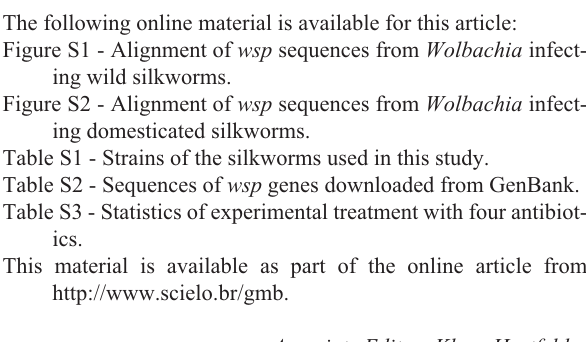
Figure S1 - Alignment of wsp sequences from Wolbachia infect- ing wild silkworms. Figure S2 - Alignment of wsp sequences from Wolbachia infect- ing domesticated silkworms. Table S1 - Strains of the silkworms used in this study. Table S2 - Sequences of wsp genes downloaded from GenBank. Table S3 - Statistics of experimental treatment with four antibiot-